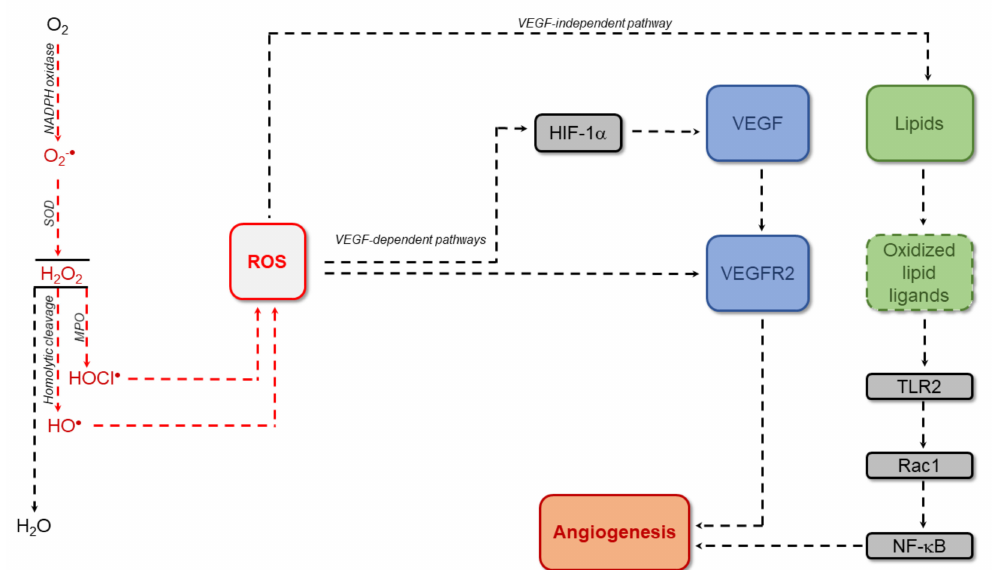
Figure 2. Oxidative stress and its e ff ect in angiogenesis: release of reactive oxygen species and generation of endogenous antioxidant pathway in mitochondria. SOD, superoxide dismutase; MPO, myeloperoxidase; ROS, reactive oxygen species; HIF, hypoxia-inducible factor; VEGF, vascular endothelial growth factor; VEGFR2, vascular endothelial growth factor / receptor; TLR, toll-like receptor; Rac1, cytosolic oxidase component; NF- κ B, factor nuclear kappa